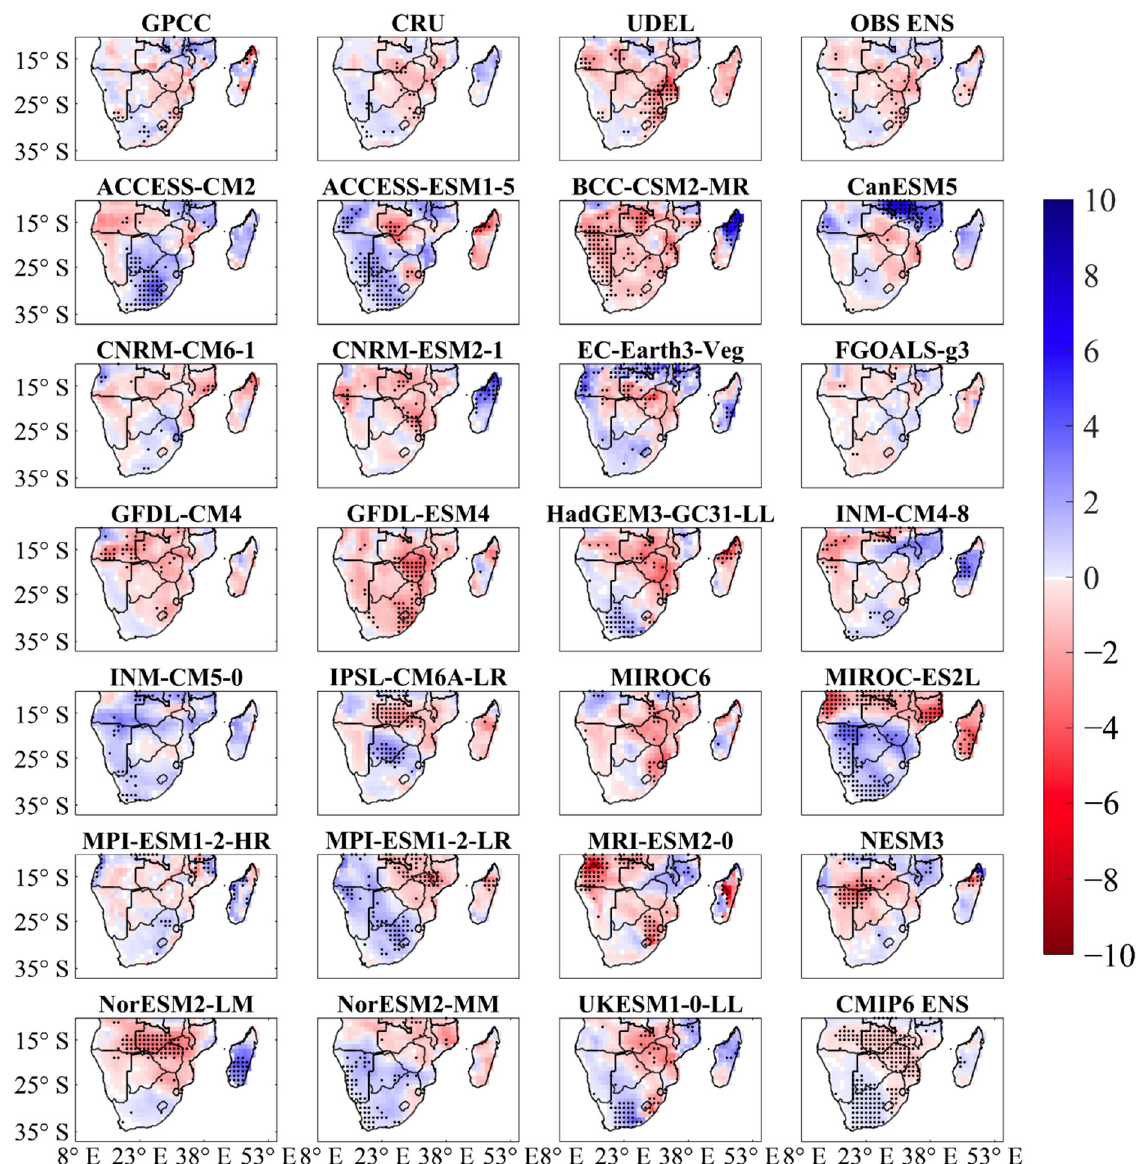
Figure 5. The same as Figure 4, but for the MJJASO season.